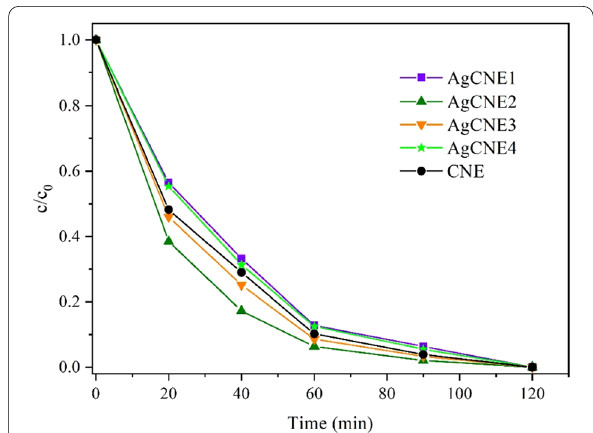
Fig. 13 Photocatalytic degradation of Ofloxacin. LED source of 420 nm and 7.1 mW cm 2; the temperature was kept at 20 −